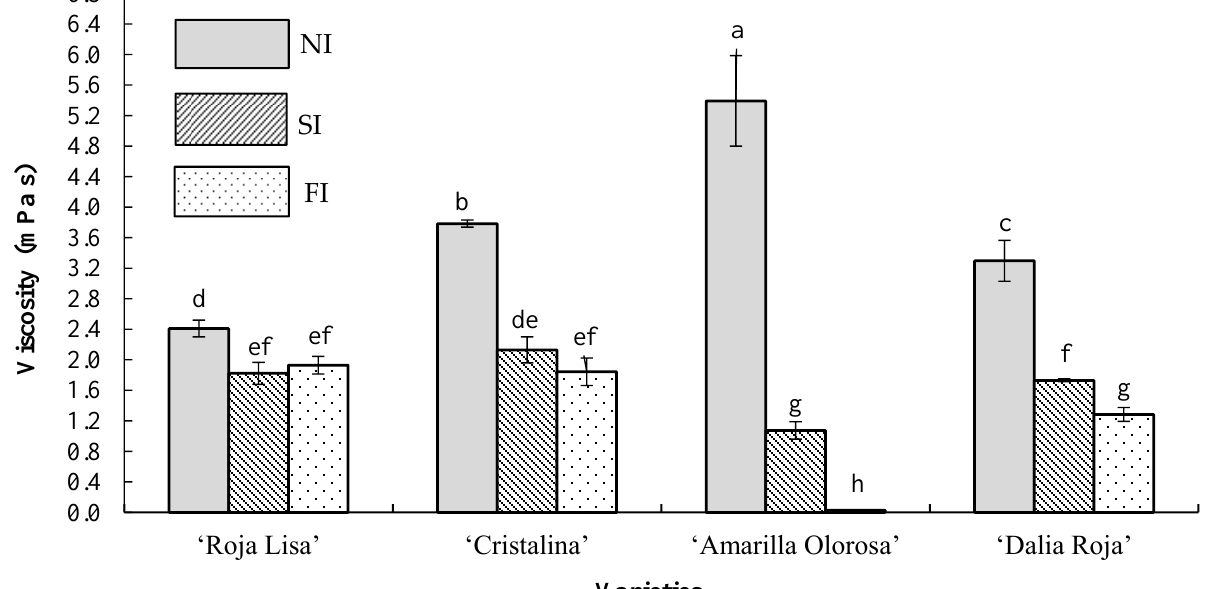
Figure 2. Viscosity (mPa s) of freeze-dried mucilage from Opuntia varieties subjected to three irrigation regimes: no irrigation (NI, control), supplemental irrigation (SI), and full irrigation (FI). Mean values ( ± standard deviation; n = 3) with different letters indicate statistical differences ( p ≤ 0.05) according to the Fisher’s least significant difference (LSD) test at p ≤ 0.05. Viscosity measurements were obtained at 25 °C with distilled water as the solvent.